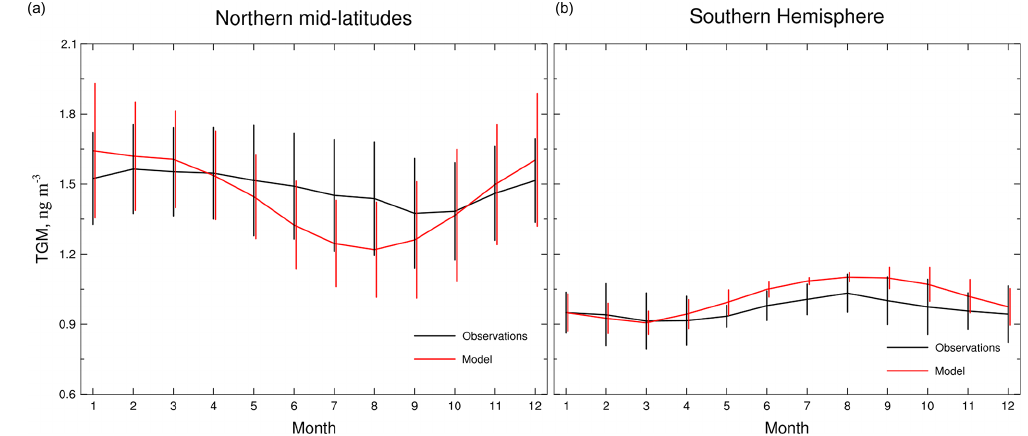
Figure 9. Seasonal variations of surface TGM concentrations in northern mid-latitudes (a) and the Southern Hemisphere (b) . Observations are the average of the available monthly data from the ground-based sites in Fig. 3, indicated by the black line. The red line represents the results simulated by CAM6-Chem/Hg model. Error bar depicts the standard deviation of TGM concentrations.